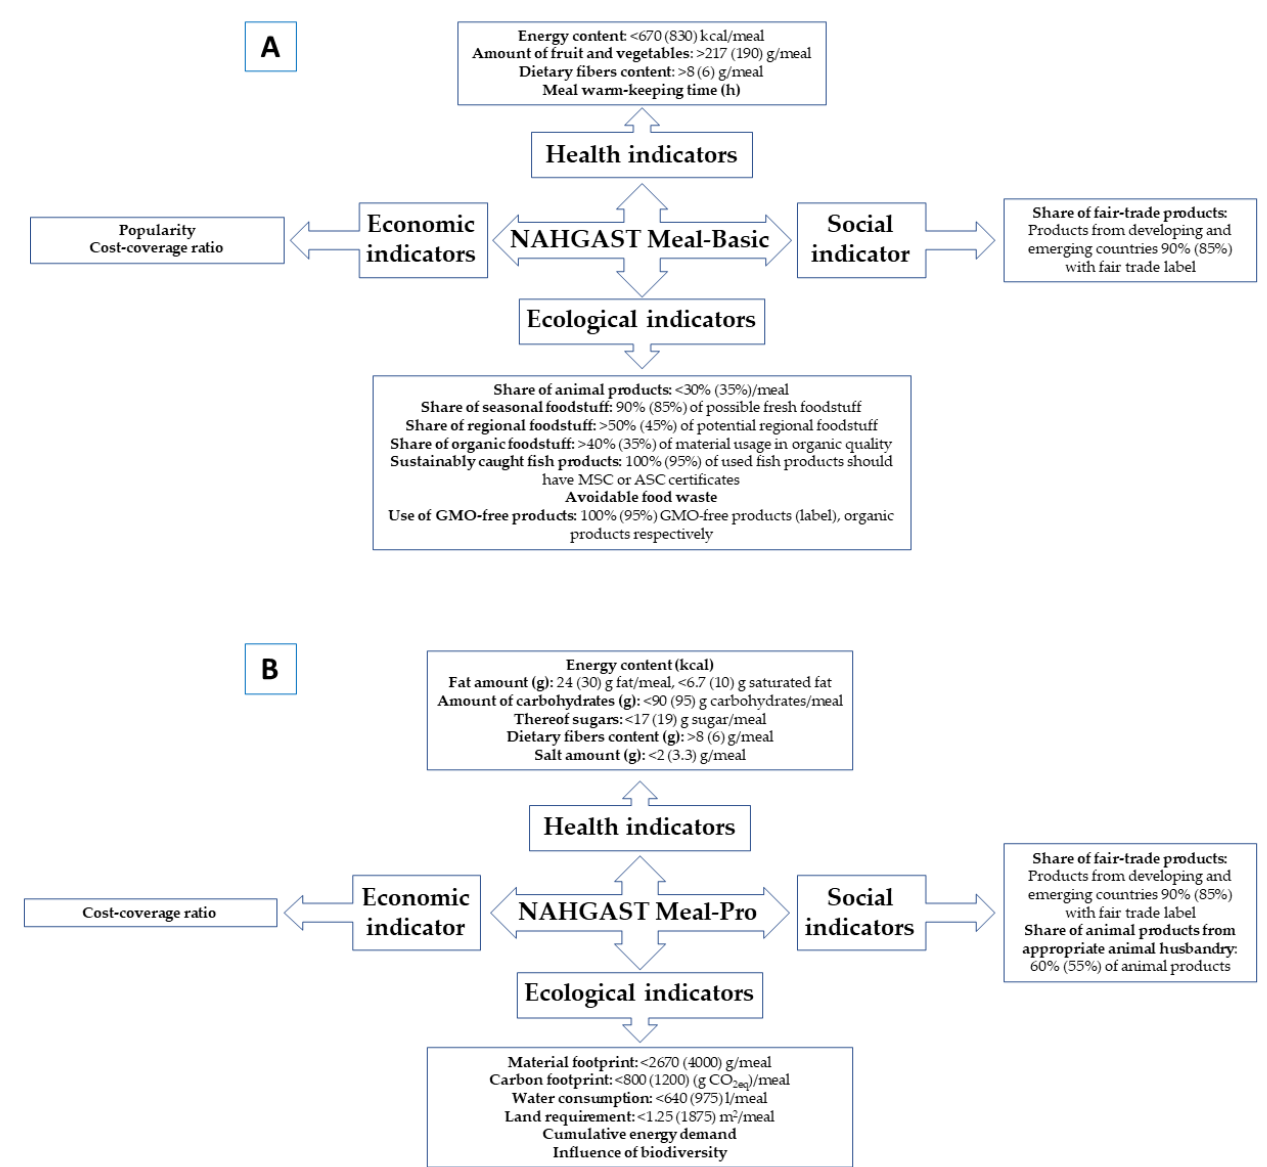
Figure 2. Differences between NAHGAST Meal-Basic ( A ) and NAHGAST Meal-Pro ( B